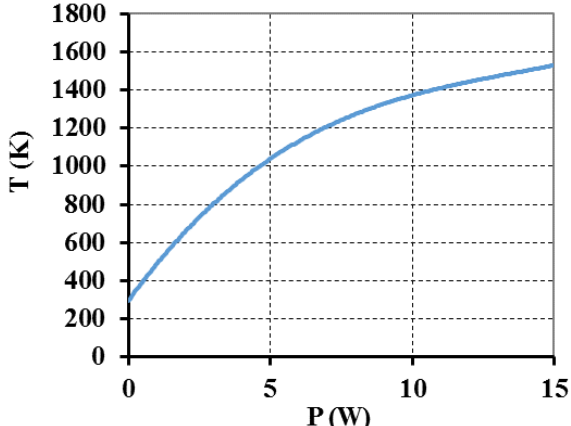
Figure 8. Plot of temperature variation with incident laser power simulated at x = y = z = 0 m. ( τ = 0.6 s; F = 0.461 N).